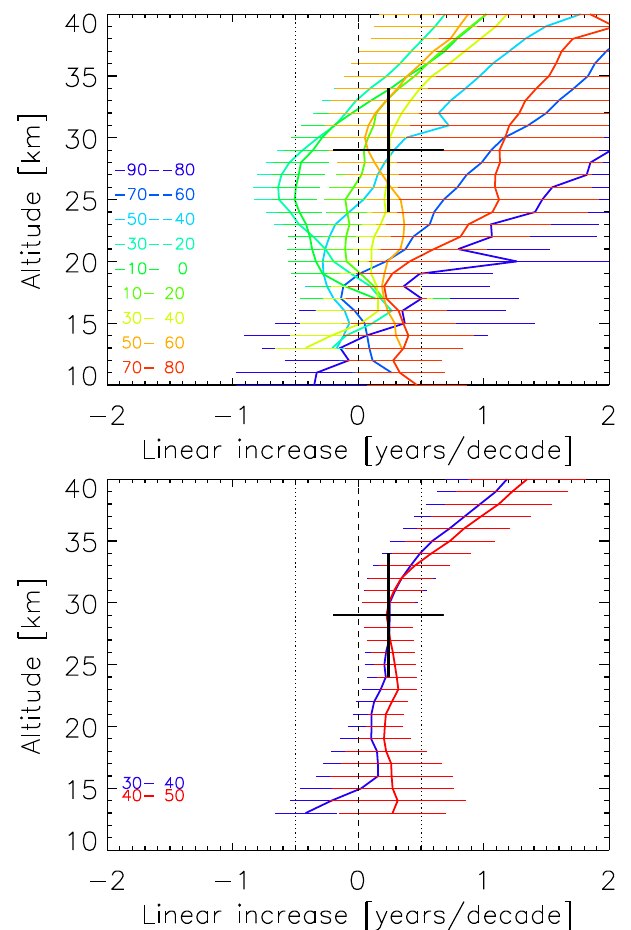
Figure 7. Vertical profiles of the age of air linear increase/decrease over the years 2002 to 2012 for example latitudes. Horizontal bars give the 2 σ uncertainties of the linear variations. The 30-year trend as derived by Engel et al. (2009) for the northern midlatitudes is also shown for comparison as a black cross indicating its valid altitude range and its 2 σ